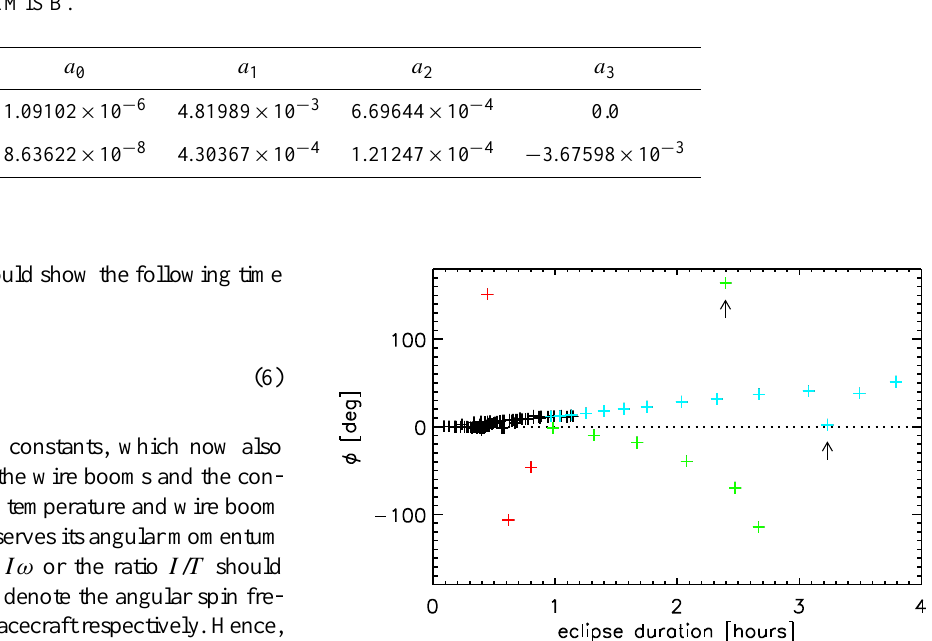
Table 1. Model parameters for THEMIS B.